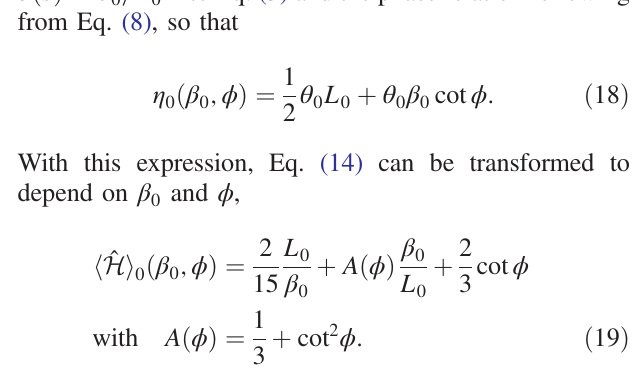
FIG. 2. Normalized phase space for dispersion. To enforce ϕ < π = 2 , ⃗ P 0 is rotated so that